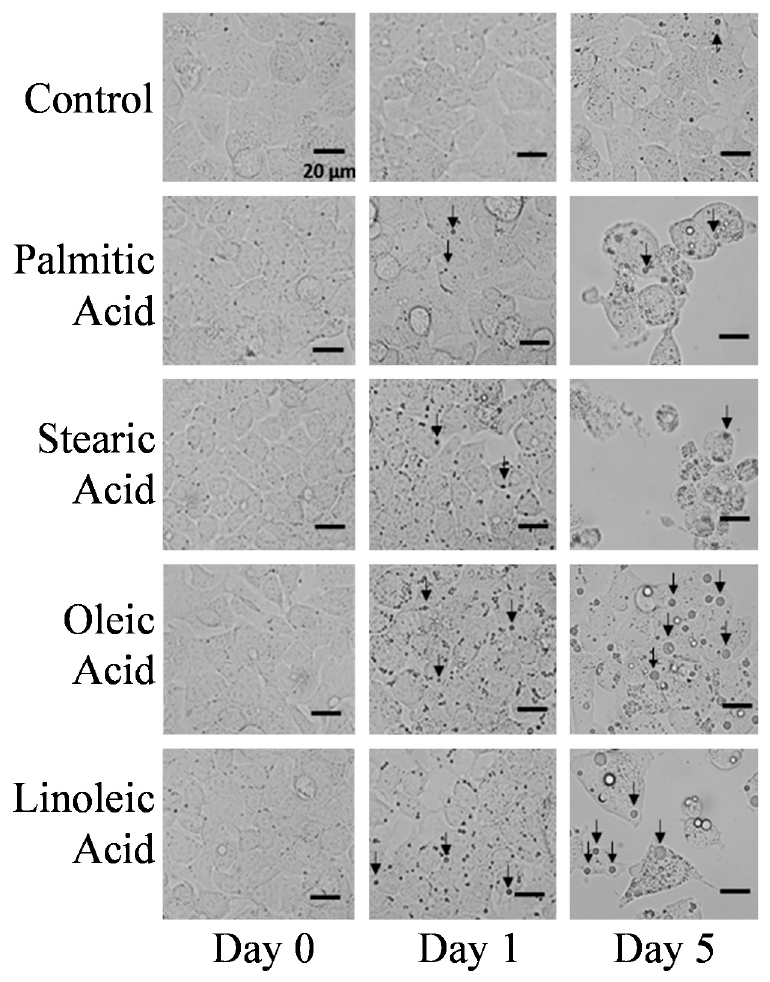
Figure 2. Optical microscopy images of HepG2 cells cultured without fatty acid (control) and with palmitic, stearic, oleic, and linoleic acids were observed on days 0, 1, and 5 of co-cultivation. Lipid droplets are indicated by arrows.